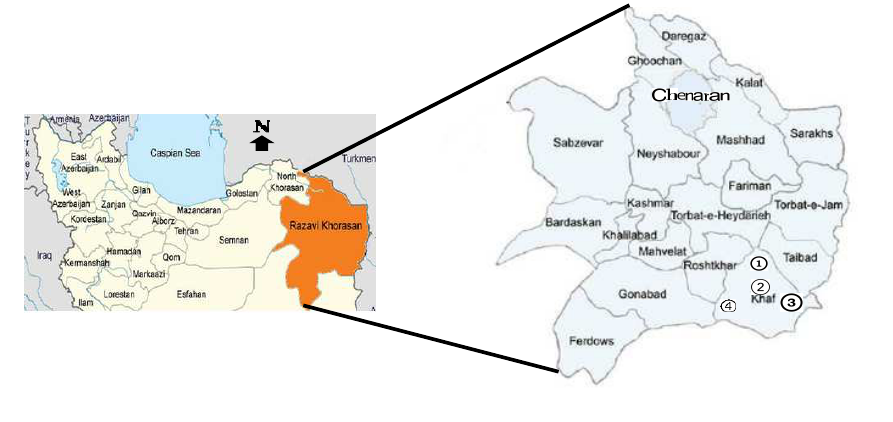
F IGURE 1. The geographic map of the sampling locality (1.Sede, 2. Khaf, 3. Sangan, 4.